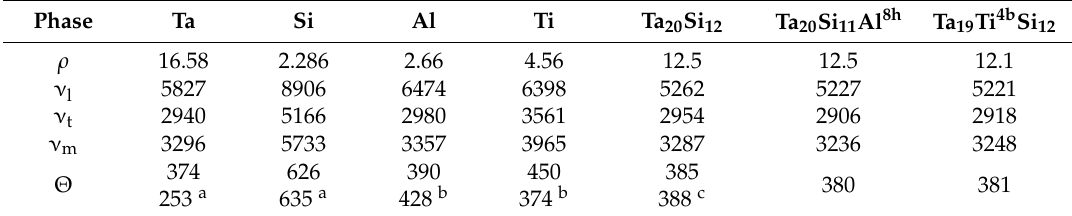
Table 4. Calculated density ρ (in g/cm 3 ), longitudinal, transverse, average sound velocities (in m/s) and Debye temperature Θ D (in K) for the binary, ternary D8 m -structured Ta 20 Si 12 and its constituent